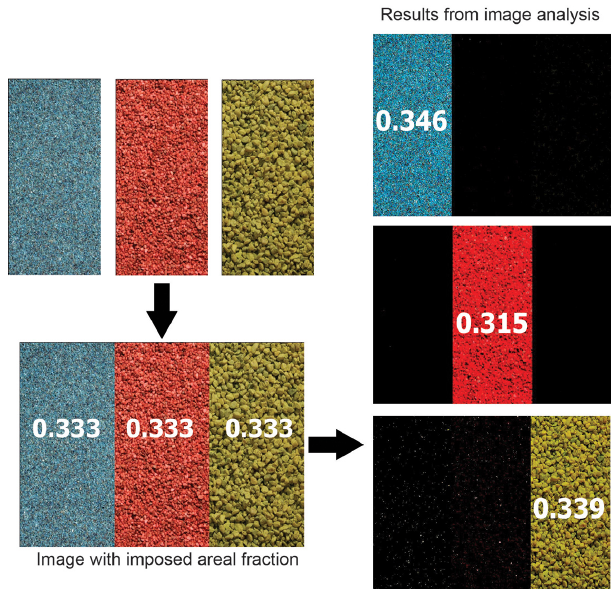
Figure 12. Accuracy test; left: Image with imposed areal fraction content created by combining three images of uniform sediment of the same pixel area; right: segmented images and mean areal frac- tion contents resulting from the image